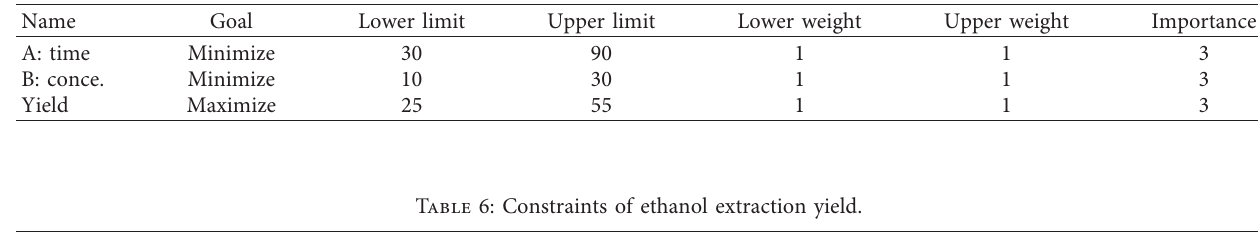
Table 5: Constraints of water extraction yield.